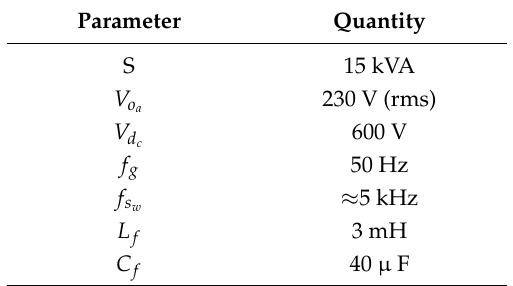
Table 1. System parameters for the simulation and experimental setup